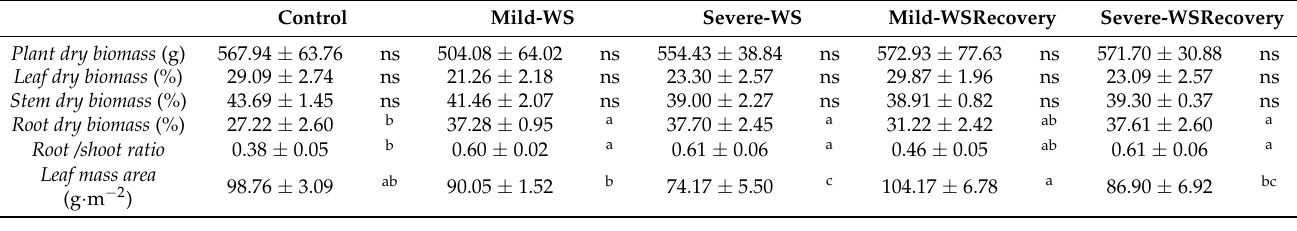
Table 1. Plant dry biomass parameters and leaf mass area (LMA) from ‘Dusa’ avocado rootstock under two different levels of water stress: mild-WS (50% of Fc) and severe-WS (25% of Fc). The table shows mean values ( ± SE; n = 4) under stress and after the corresponding recovery. Different letters indicate significant differences among treatments ( p < 0.05, ns: no statistical differences).